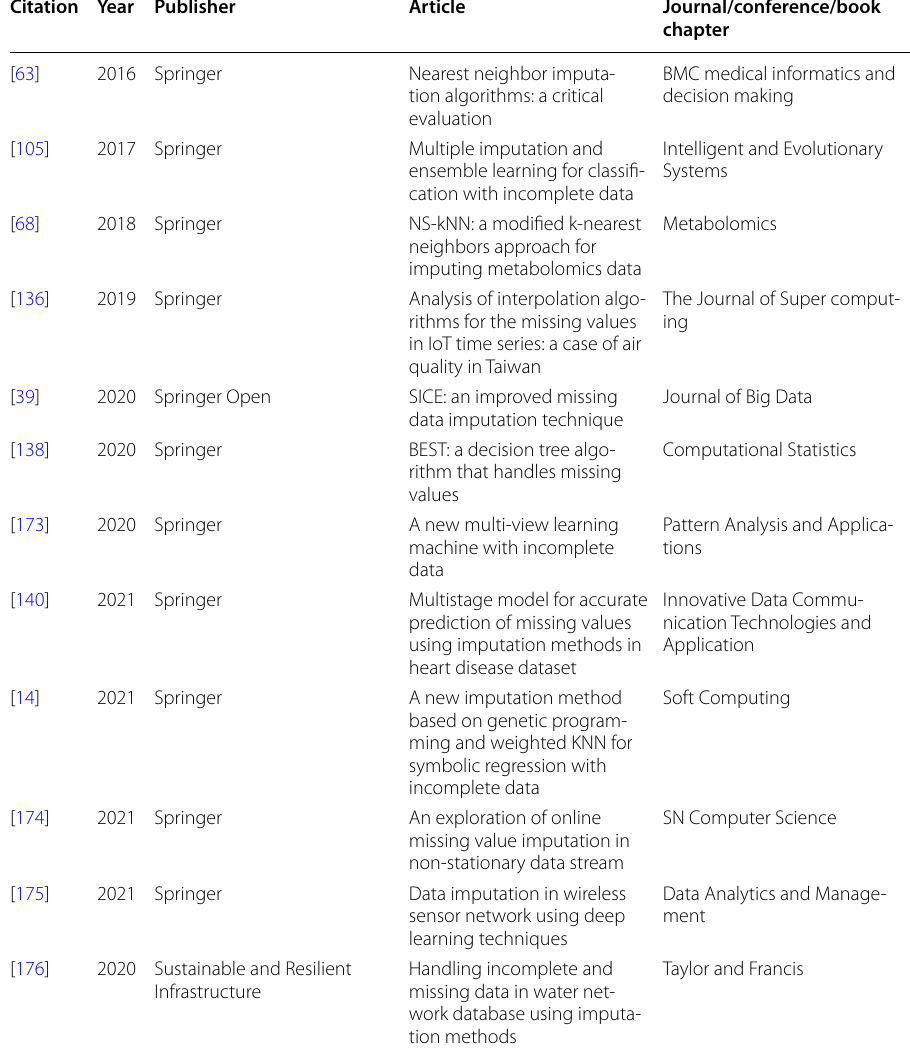
the sepal and the petal (in cm). We also experimented on an Induced draft fan (ID fan) dataset from a local coal-fired power plant where real data of a coal power plant fan system was recorded. The dataset contains readings for the month of February 2021 of a single unit of the power plant. The ID fan vibrations are measured by sensors and were recorded by the technicians every 4 h when the plant was running. These variables spe- cifically consist of bearing vibrations and temperatures, at the fan non-drive end (FNDE) and fan drive end (FDE), motor temperatures and vibrations, at the motor non-drive end (MNDE) and motor drive end (MDE). The values of the ID fan are recorded as part of the daily power plant monitoring system. Both the Iris and ID Fan datasets contain 150 instances with no missing values. Our method simulates the missing values on sepal length and petal width of the Iris data and the Vibrations on the ID fan data. The tar- get missingness fraction was set to MCAR by setting the probability of a value to